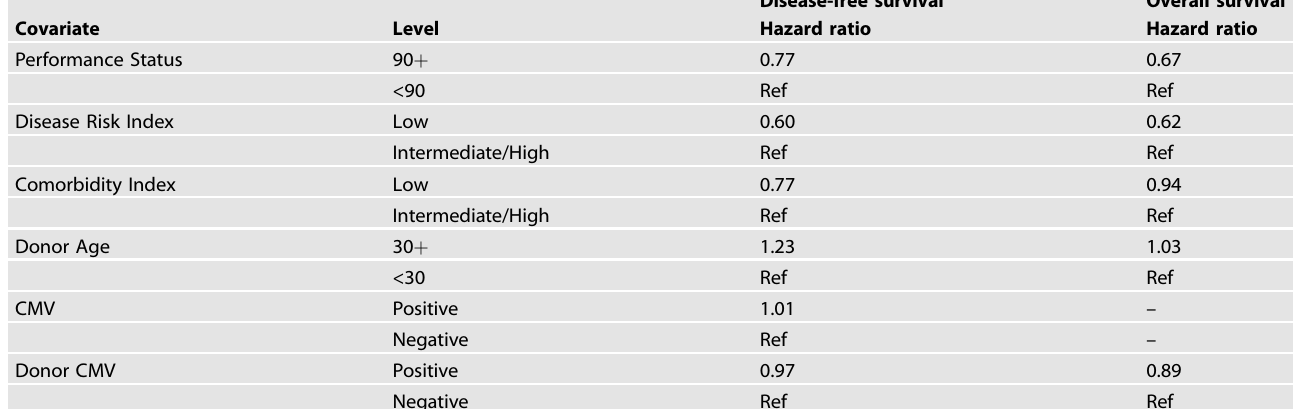
Table 2. Variables selected for the model.